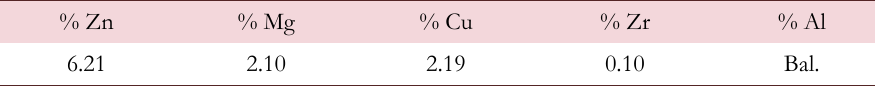
Table 1: Nominal chemical composition of the alloy